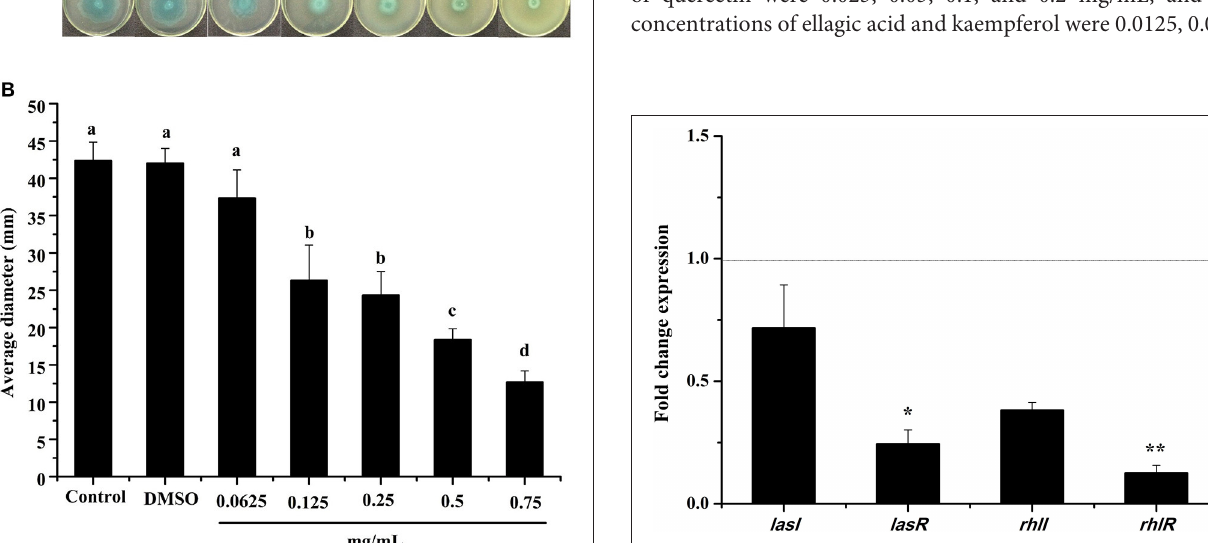
FIGURE 4 | Swimming inhibition assay. Swimming agar inoculated with the dichloromethane fraction of the Camellia nitidissima Chi flowers (A), and average diameter of the bacterial colony (B) . Means with different small letters (a–e) are significantly different ( p < 0.05).